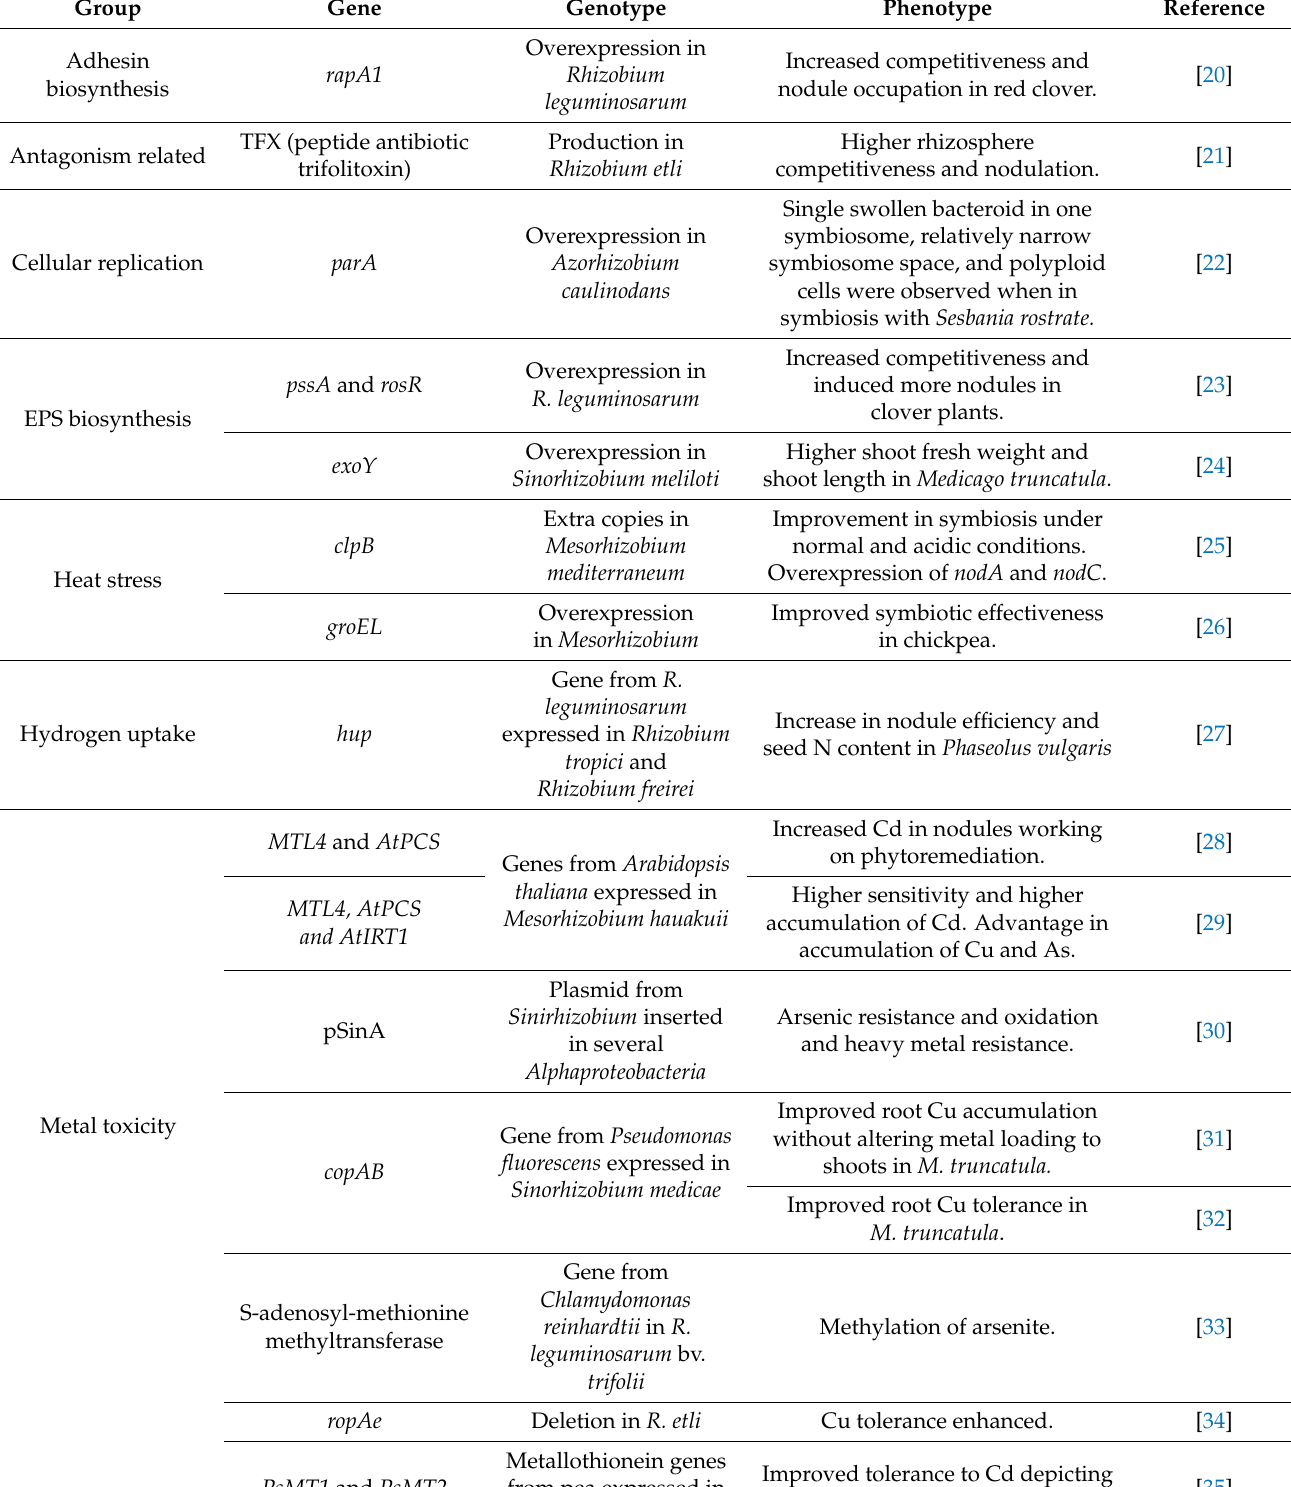
Table 1. Modification of rhizobial strains to improve survival and nitrogen fixation